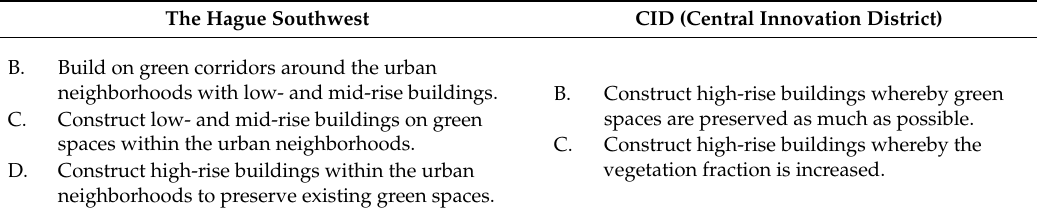
Figure 3. Theoretical building assignment for districts of The Hague Southwest (panel A ) and the CID (panel B ). The building assignment is indicated for different neighborhoods within brackets, and the number above the brackets indicates the current number of residences in the neighborhood. The pink areas in panel A indicate green corridors which were built using strategy C. The white numbers label the different neighborhoods. Table 1. Five urban planning strategies that complete the building assignments for The Hague Southwest and the Central Innovation District (CID). The enumeration starts with B, in accordance with the panels in Figures 8 and 10. Panel A in these figures represents the current